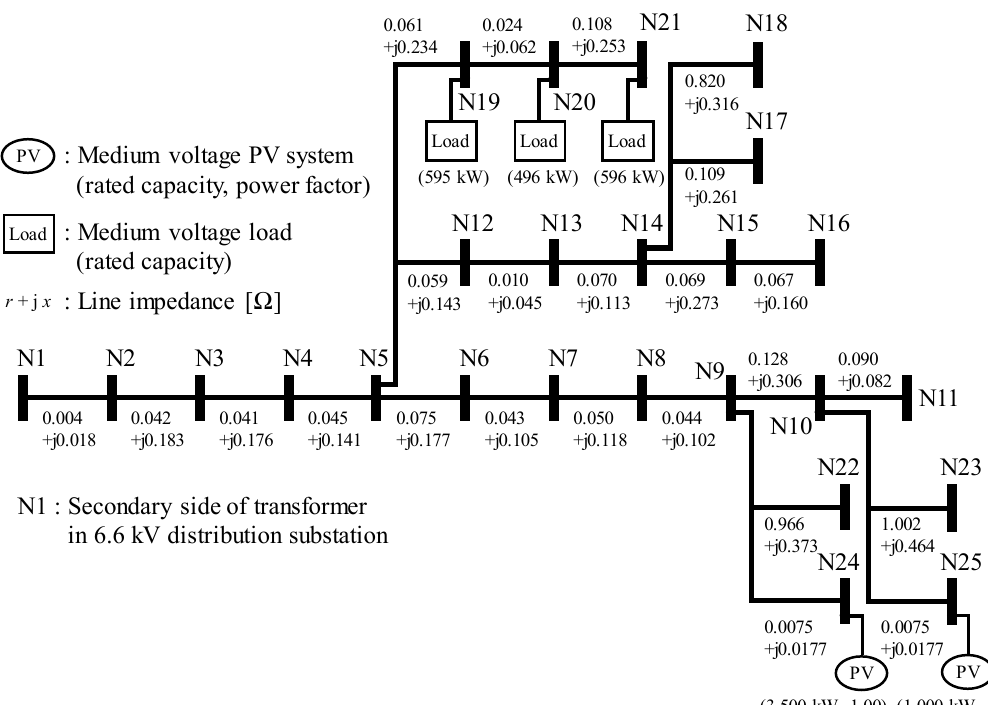
Figure 15. Another MV distribution system model that corresponds to the actual distribution feeder.